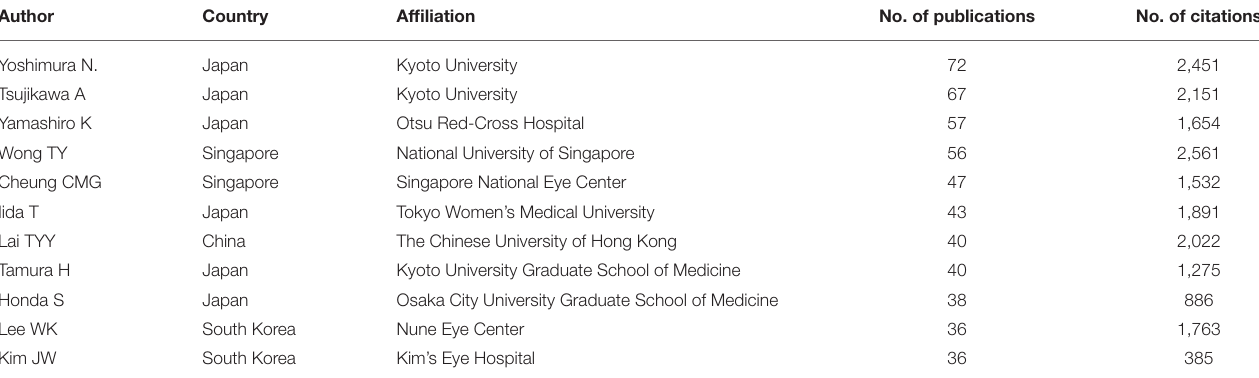
TABLE 2 | Top 10 author who published most in this